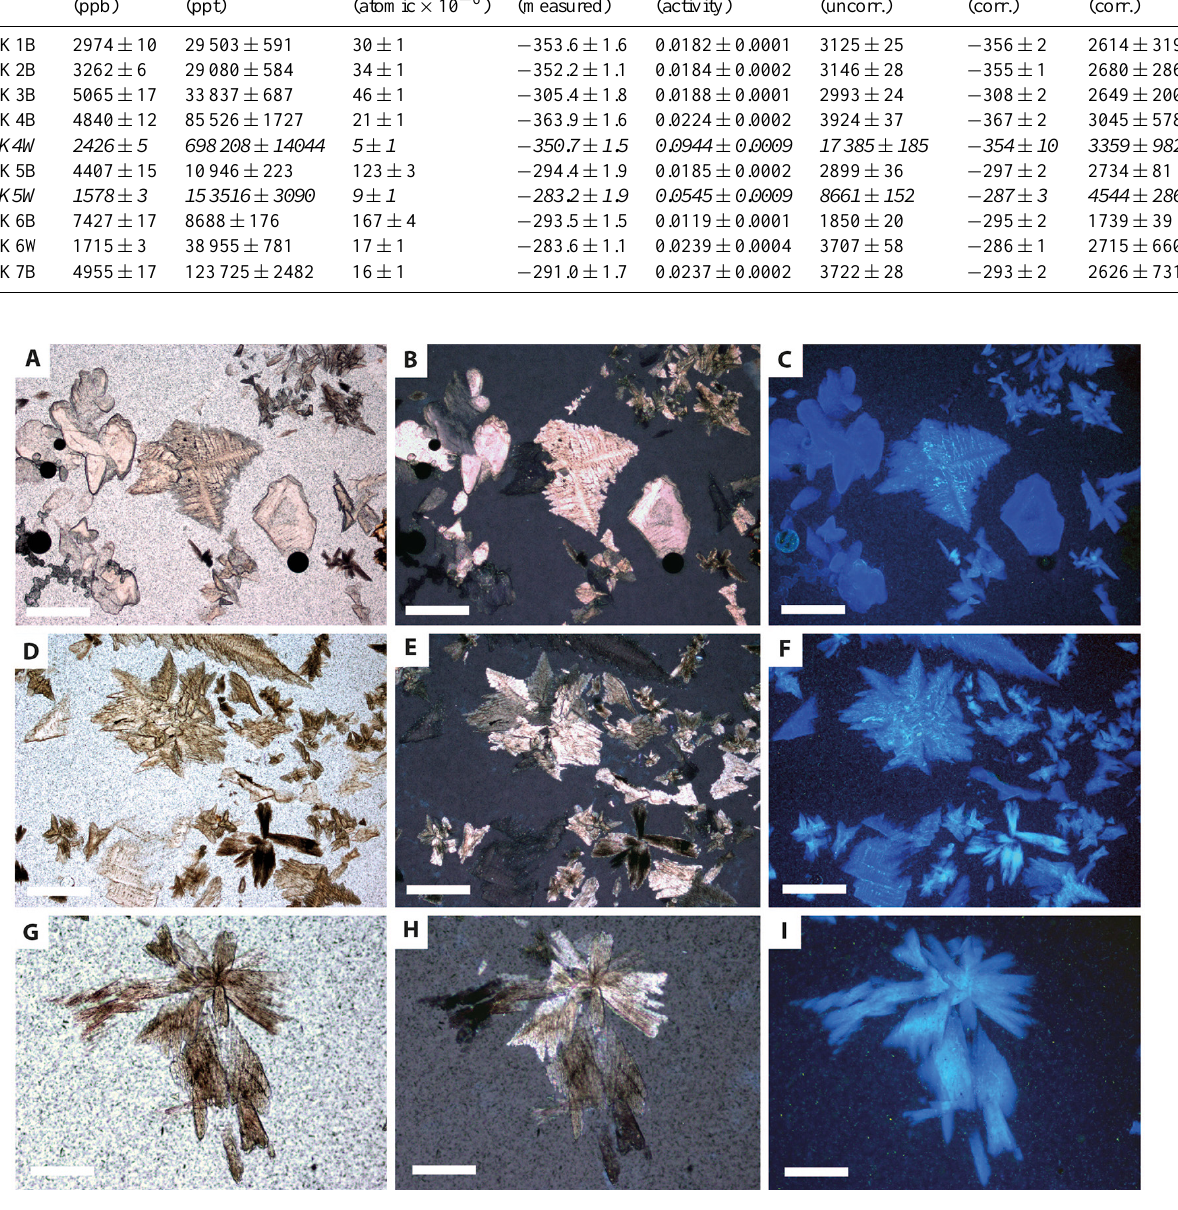
Figure 9. Appearance of cryogenic calcite crystals in thin sections. (a) Dendritic crystal (center) and fragments of rhombohedral crystals nearby as well as smaller aggregates of the white crystal population (e.g., right-hand upper corner of image). Plane-polarized light. (b) Same under partially cross-polarized light. (c) Same under epifluorescence. In (a–c) black rounded spots are air bubbles in the epoxy resin. (d) Mixture of aggregates of rhombohedral crystals, spear-like aggregates (partially visible near upper margin of the image) and few aggregates of the white crystal population (lower right corner). (e) Same under cross-polarized light. (f) Same under epifluorescence. (g) Close-up of a rosette-like aggregate of the white crystal population, which appears brown and rich in minute inclusions in transmitted light. (h) Same under partially cross-polarized light. (i) Same under epifluorescence. Scale bars are 500µm in (a–f) and 200µm in (g–i) . (a–c) is sample MSK5 and the remaining images are from sample